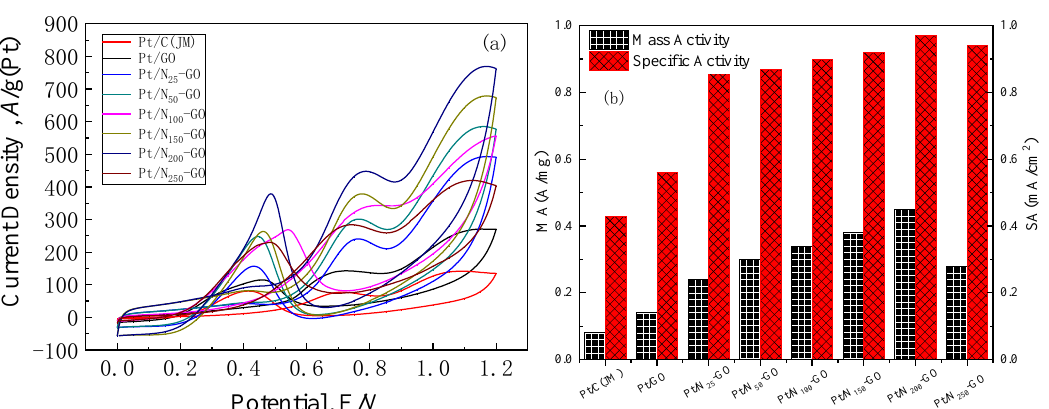
Figure 7. ( a ) Cyclic voltammograms recorded for the catalysts in a solution of 1 mol/L CH 3 CH 2 OH and 0.5 mol/L H 2 SO 4 . ( b ) Histogram of mass activity and specific activity of each group of catalysts.